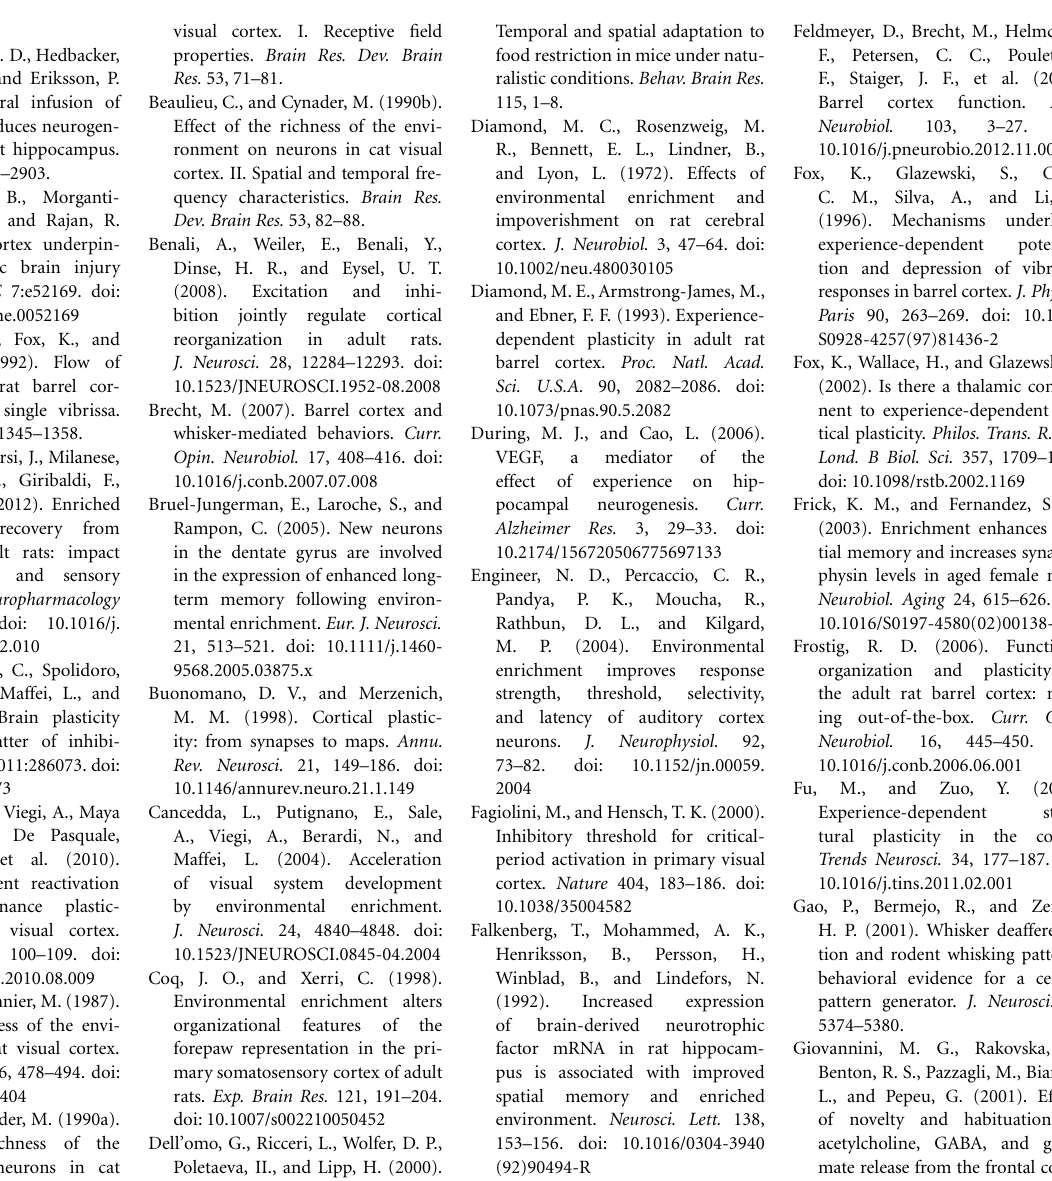
lists F statistics and degrees of freedom for both significant and non-significant factors for main and interaction terms. Table S4 | Results of Two-Way repeated measures ANOVA statistical analysis of firing rate (PFR) and Latency to Peak (L PFR ) in clusters responsive to the rough surface discrimination whisker motion stimulus from 5 to 30ms from stimulus onset (related to Figures 4B,C). The table lists F statistics and degrees of freedom for both significant and non-significant factors for main and interaction terms. Table S5 | Results of Two-Way repeated measures ANOVA statistical analysis of firing rate (PFR) in clusters responsive to the exploratory “free whisking” stimulus from 5 to 200ms from stimulus onset (related to Figure 6A); and firing rate (PFR) and Latency to Peak (L PFR ) from 5 to 50ms from stimulus onset (related to Figures 6B,C). The table lists F statistics and degrees of freedom for both significant and non-significant factors for main and interaction